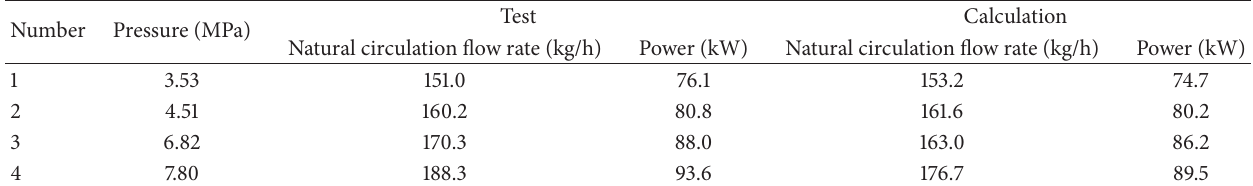
Table 3: Effect of the initial pressure.